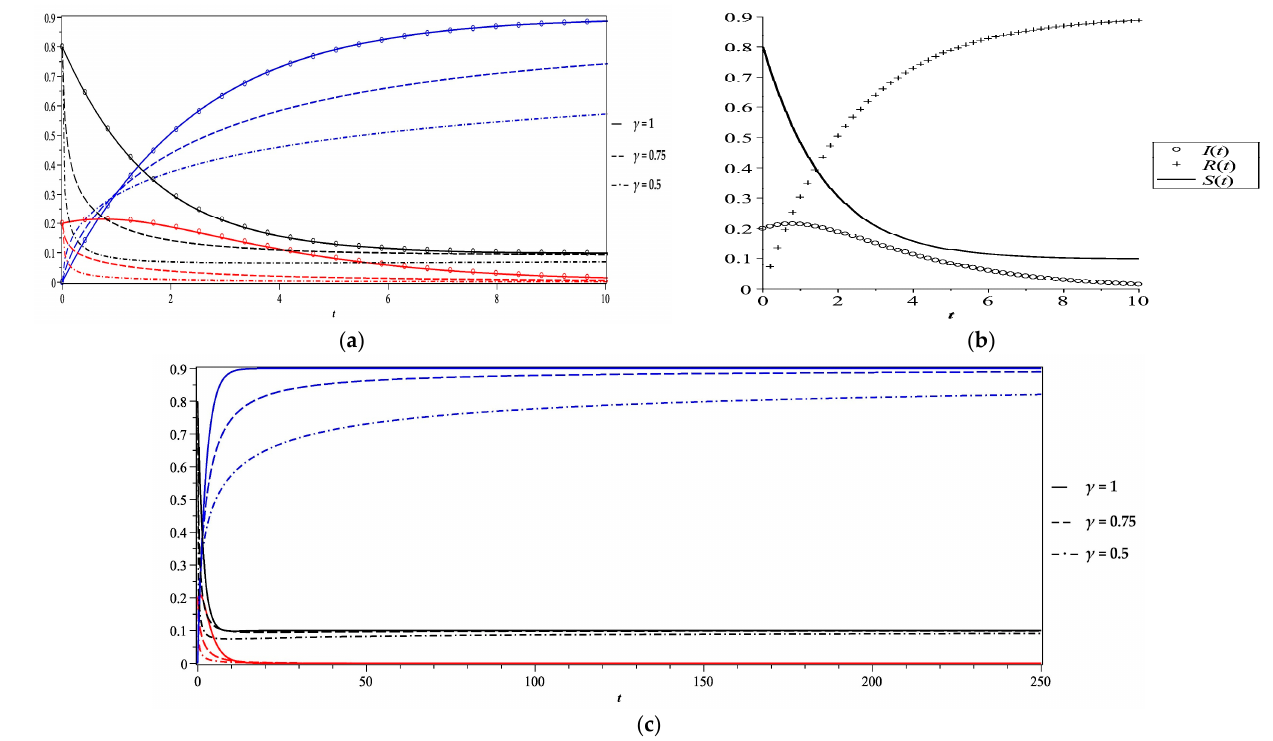
Figure 3. Behavior of various individual fractions ( S in black , I in red and R in blue) versus time for Case 2 at different fractional order values ( a ) till T = 10, ( b ) results of [3] and ( c ) till T = 250.